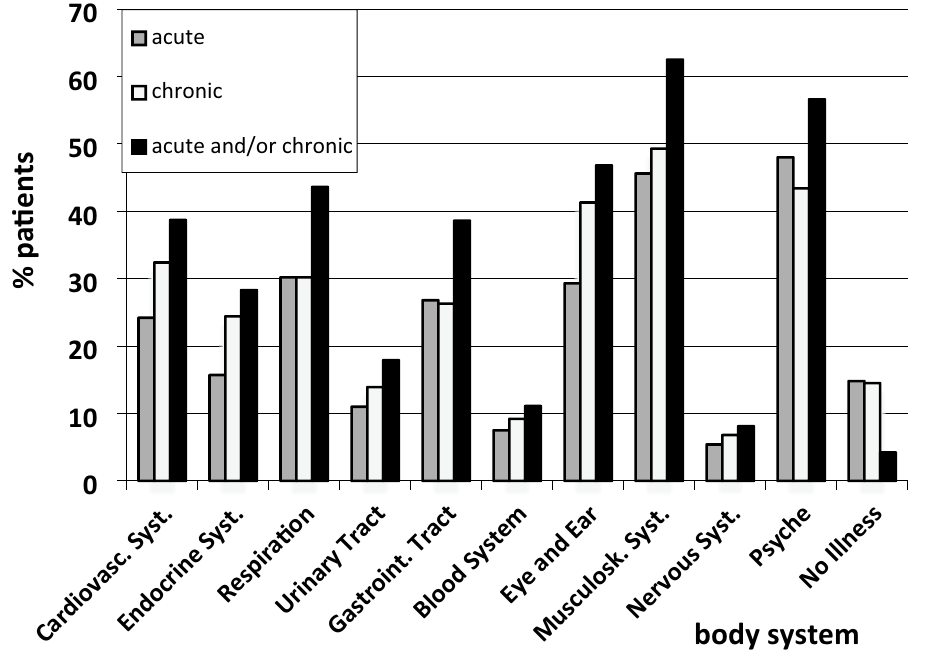
Figure 1. Percentage of patients awaiting a GP consultation according to acute and chronic disease and impaired body system.